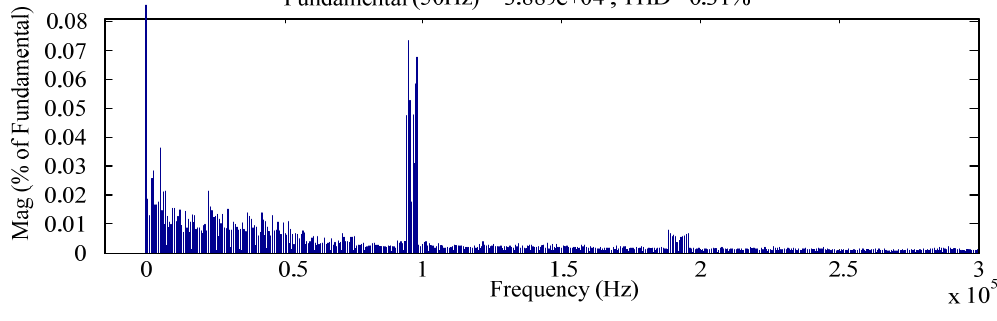
Figure 12. The Total Harmonic Distortion (THD) of voltage of the traction